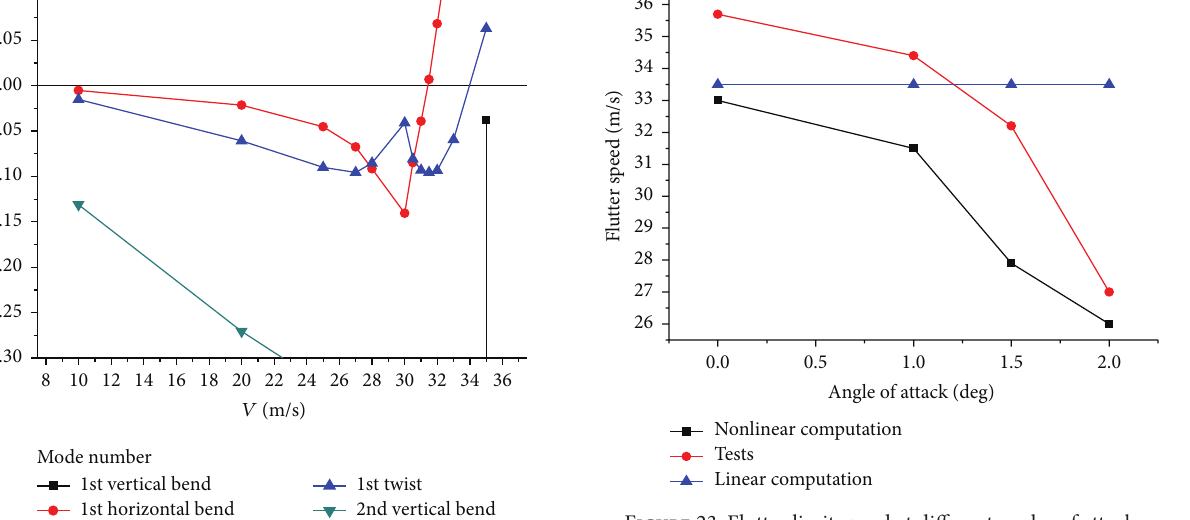
Figure 23: Flutter limit speed at different angles of